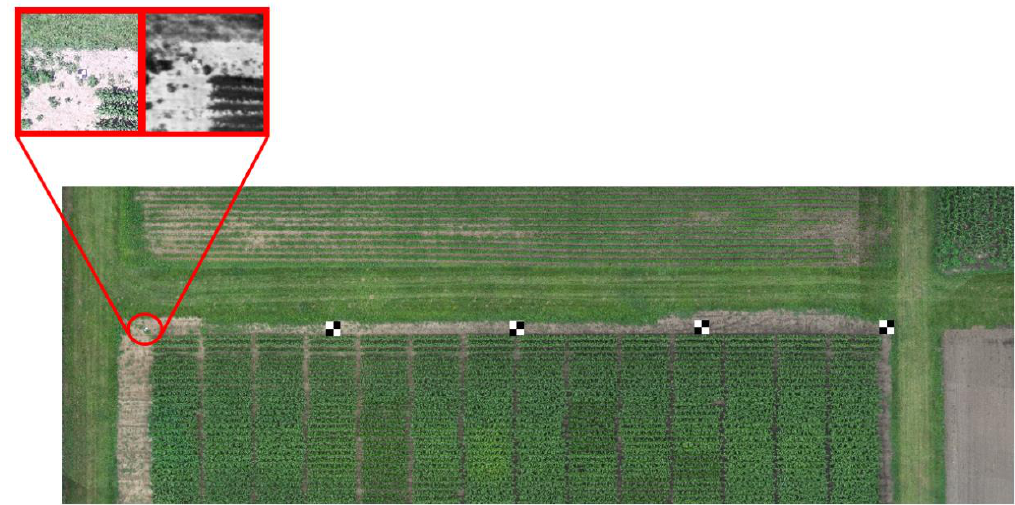
Figure 13. Flight area with enhanced representations of checkerboard targets and sample thermal and RGB images of the FLIR camera around the target location.